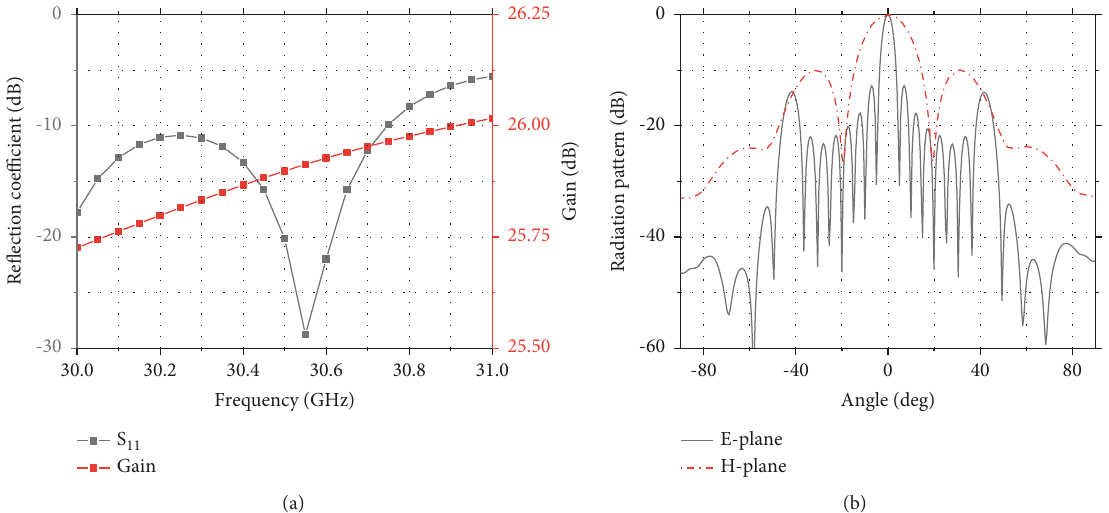
Figure 7: Simulated (a) |S11|, gain, and (b) radiation patterns of the 2